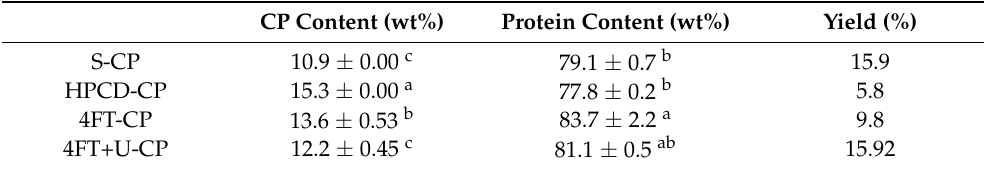
Table 1. The CP content, protein content, and yield of CPs obtained by different extraction methods in wet mass.